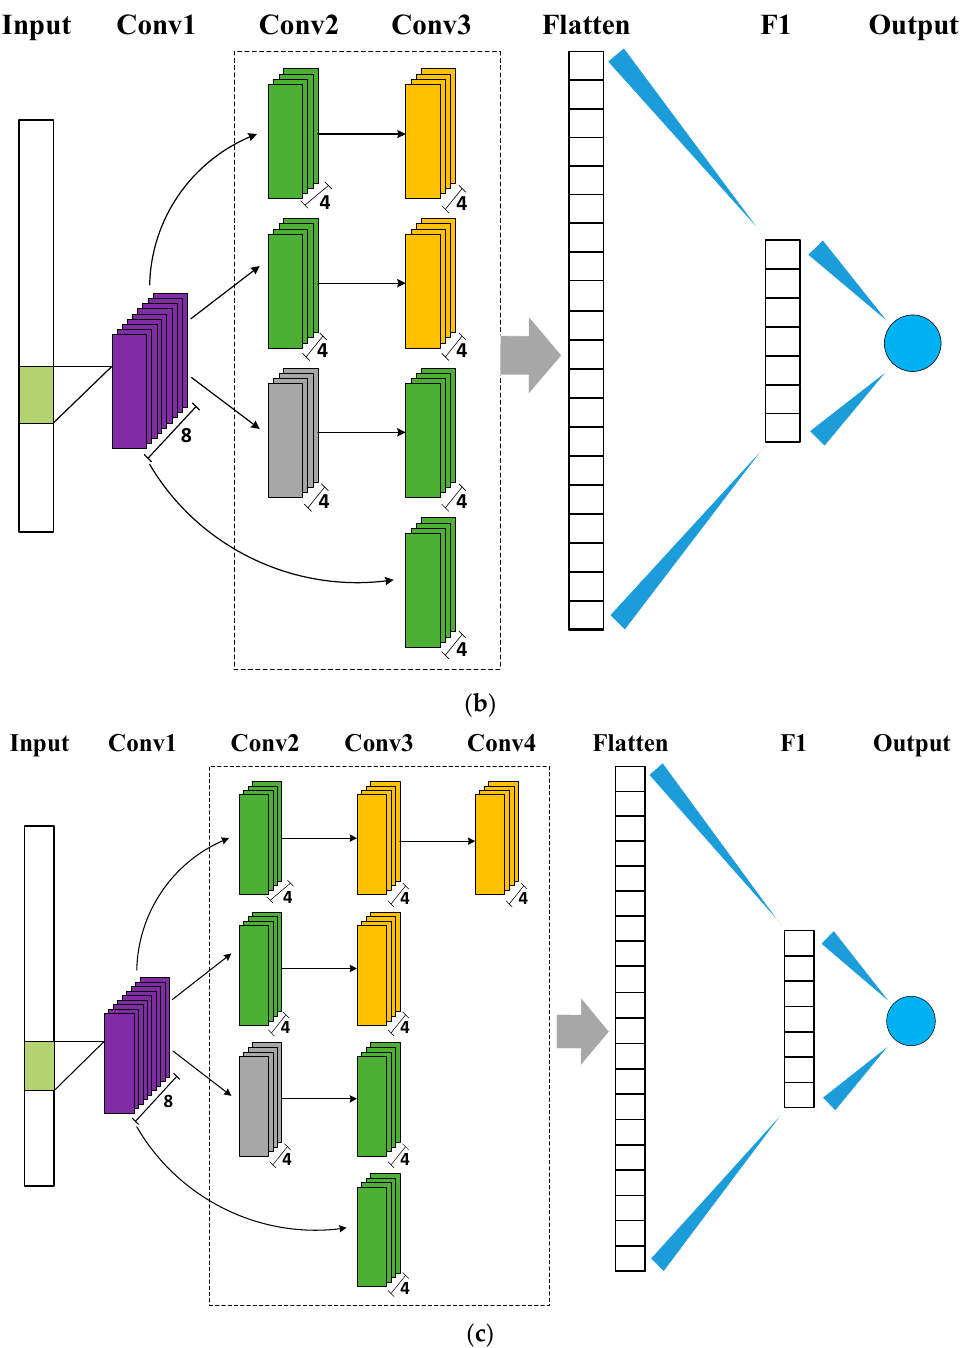
Figure 3. Architectures of three convolutional neural network (CNN) models incorporated Inception module. ( a ) Model 1. ( b ) Model 2. ( c ) Model 3.